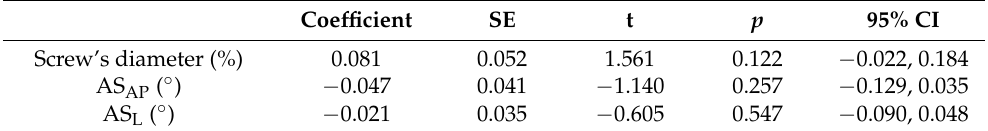
Table 4. Multiple linear regression analysis of the time needed to achieve fracture union with the screw diameter and position of implants in patients treated with 2